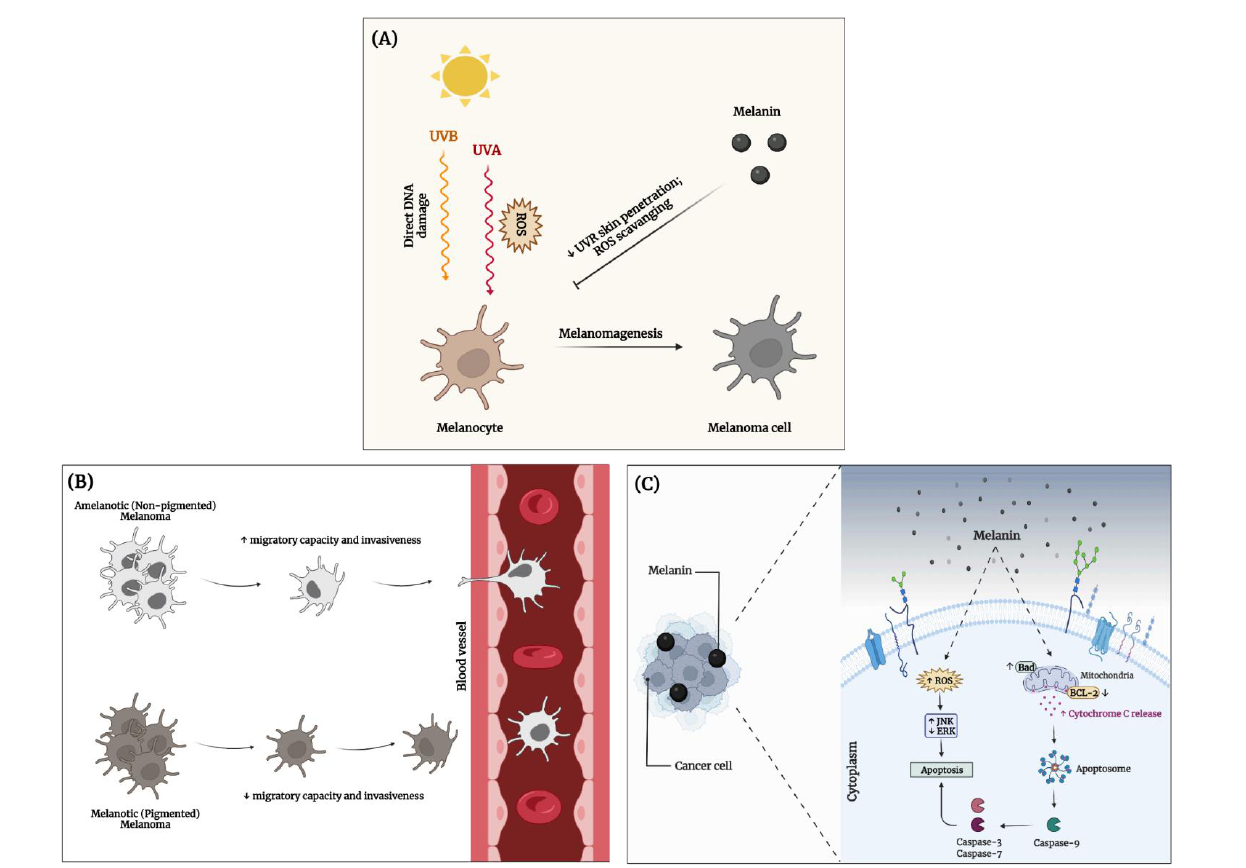
Figure 3. Melanin implications in cancer development. ( A ) Cancer prevention—melanin counter- acts UVR-induced damage and melanomagenesis; ( B ) cancer metastasis—differential metastatic potential of melanoma cells depending on the presence of intracellular melanin; and ( C ) cancer treatment—melanin exerts a pro-apoptotic effect against cancer cells. This image was created using BioRender (BioRender.com). ↑ increased; ↓